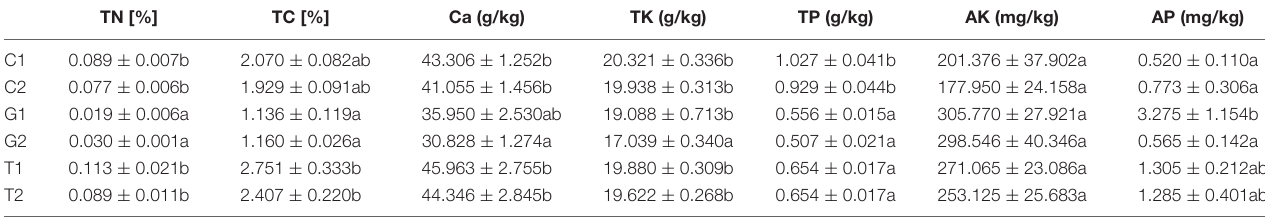
TABLE 1 | Soil nutrients in each sample group.